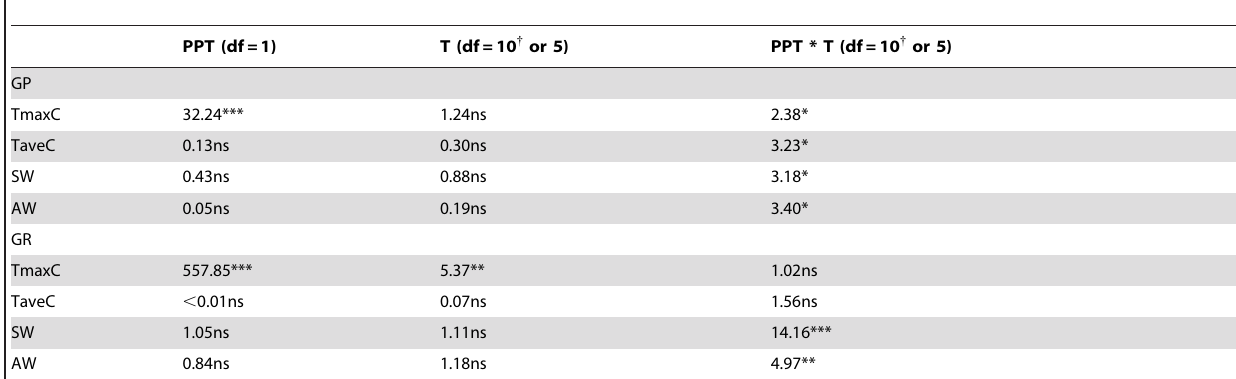
Table 2. The two-way ANOVA analysis of the effects of plant photosynthetic type (PPT) and temperature treatments (T) in four temperature regimes on germination percentage and germination